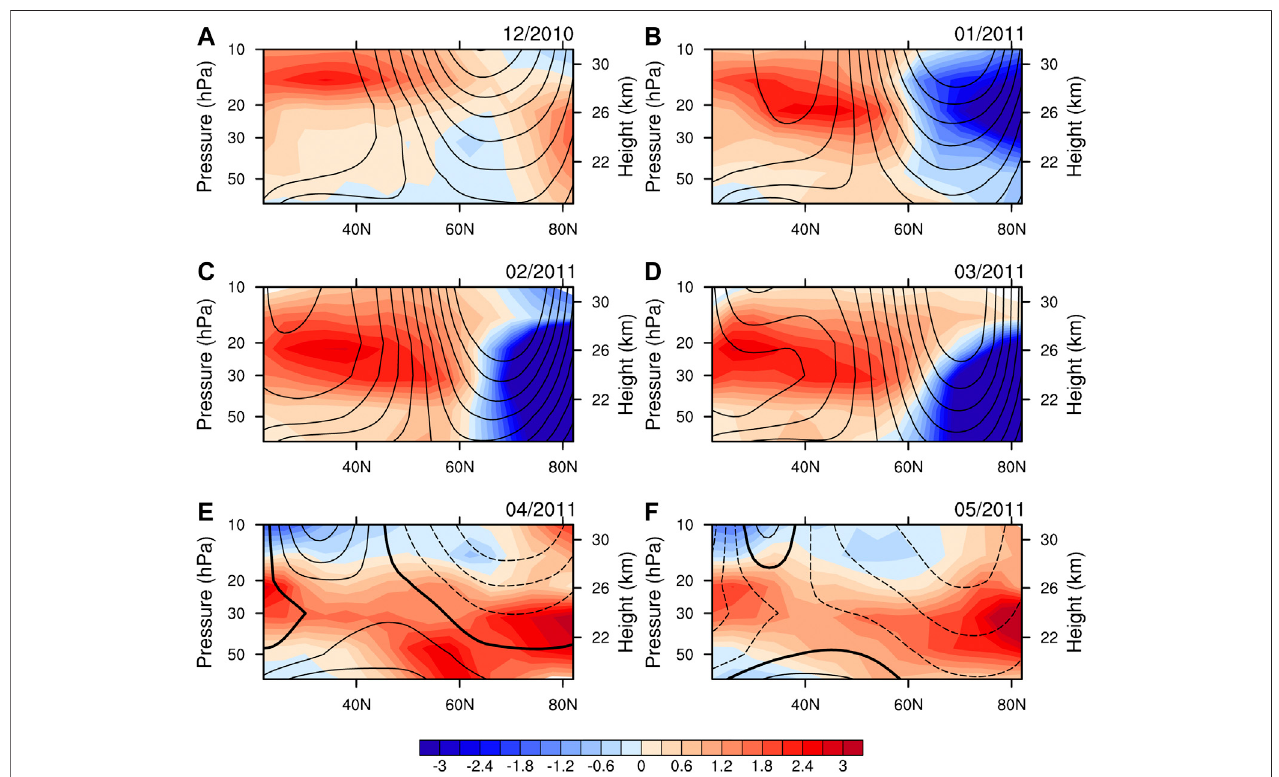
FIGURE 2 | (A – H) Month-to-month evolution of Northern Hemisphere stratospheric HCl anomalies (color shading, 10 − 1 ppbv) and zonal-mean zonal wind (U; contours, interval is 4 m s − 1 ) from December 2010 to May 2011. The anomalies are obtained by removing the seasonal cycle from 2005 to 2012. Thin solid lines represent positive U, dotted lines are negative U, and the thick solid line represents the zero line. HCl data are from MLS and U data are from ERA-Interim.